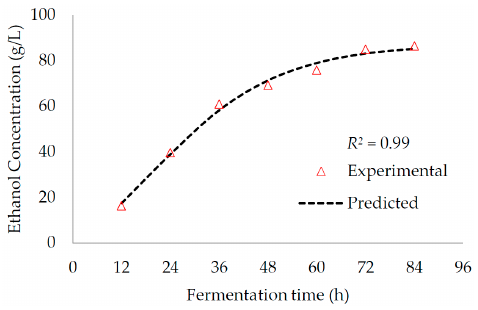
Figure 4. Fitting of modified Gompertz model to the experimental data for M. glaziovii ethanol production.